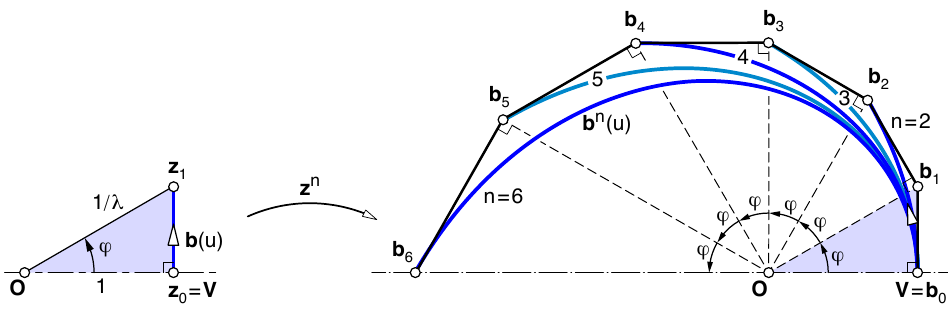
Figure 4. Degree- n typical curves with endpoint b 0 at the vertex V , ( n = 2,3,4,5,6 ) .